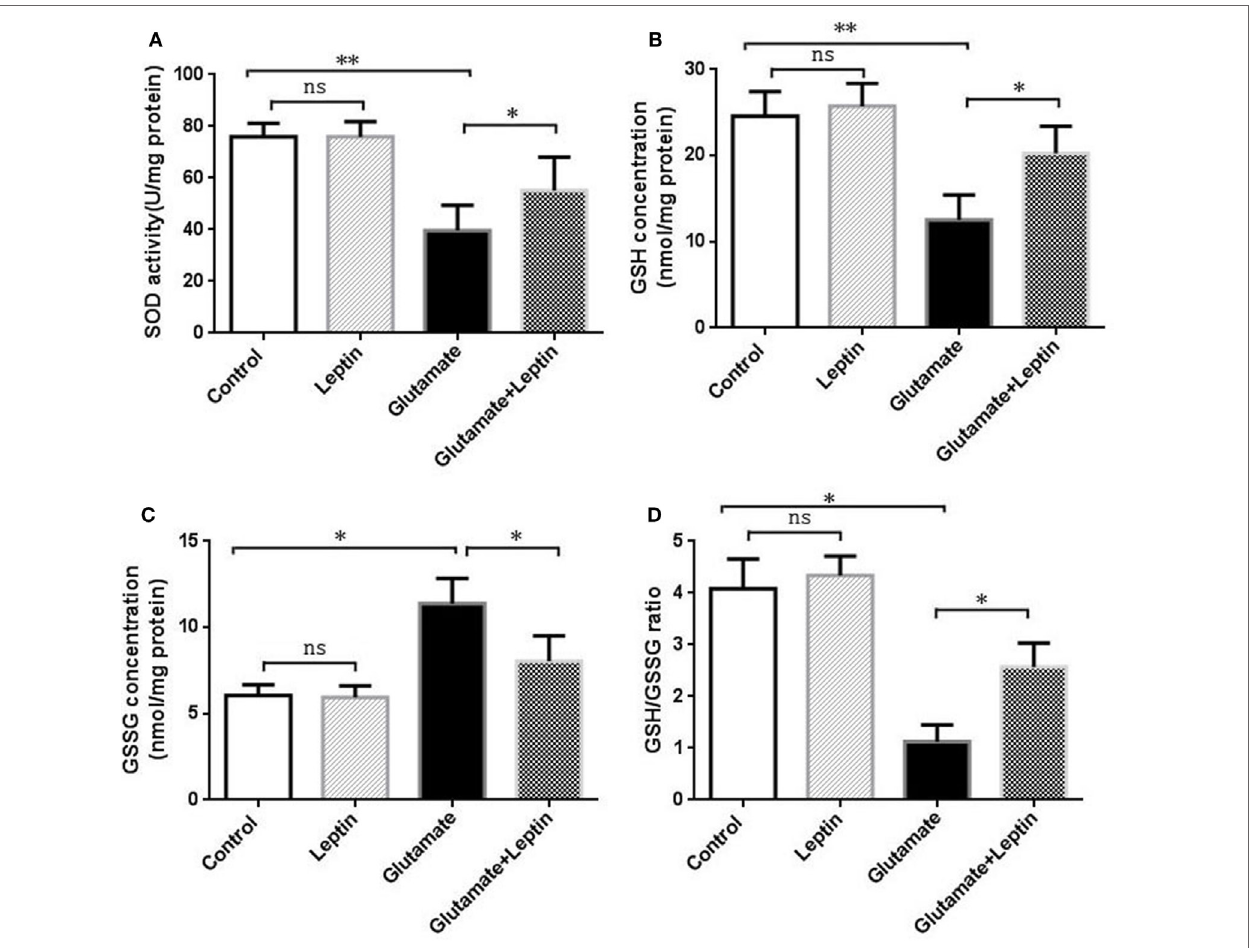
FigUre 2 | Antioxidant function of leptin against glutamate-induced oxidative stress in HT22 cells. (a) The effect of leptin on superoxide dismutase activity; (B) the effect of leptin on GSH concentration; (c) the effect of leptin on GSSG concentration; (D) the effect of leptin on the GSH/GSSG ratio. * P < 0.05, ** P < 0.01. ns, not